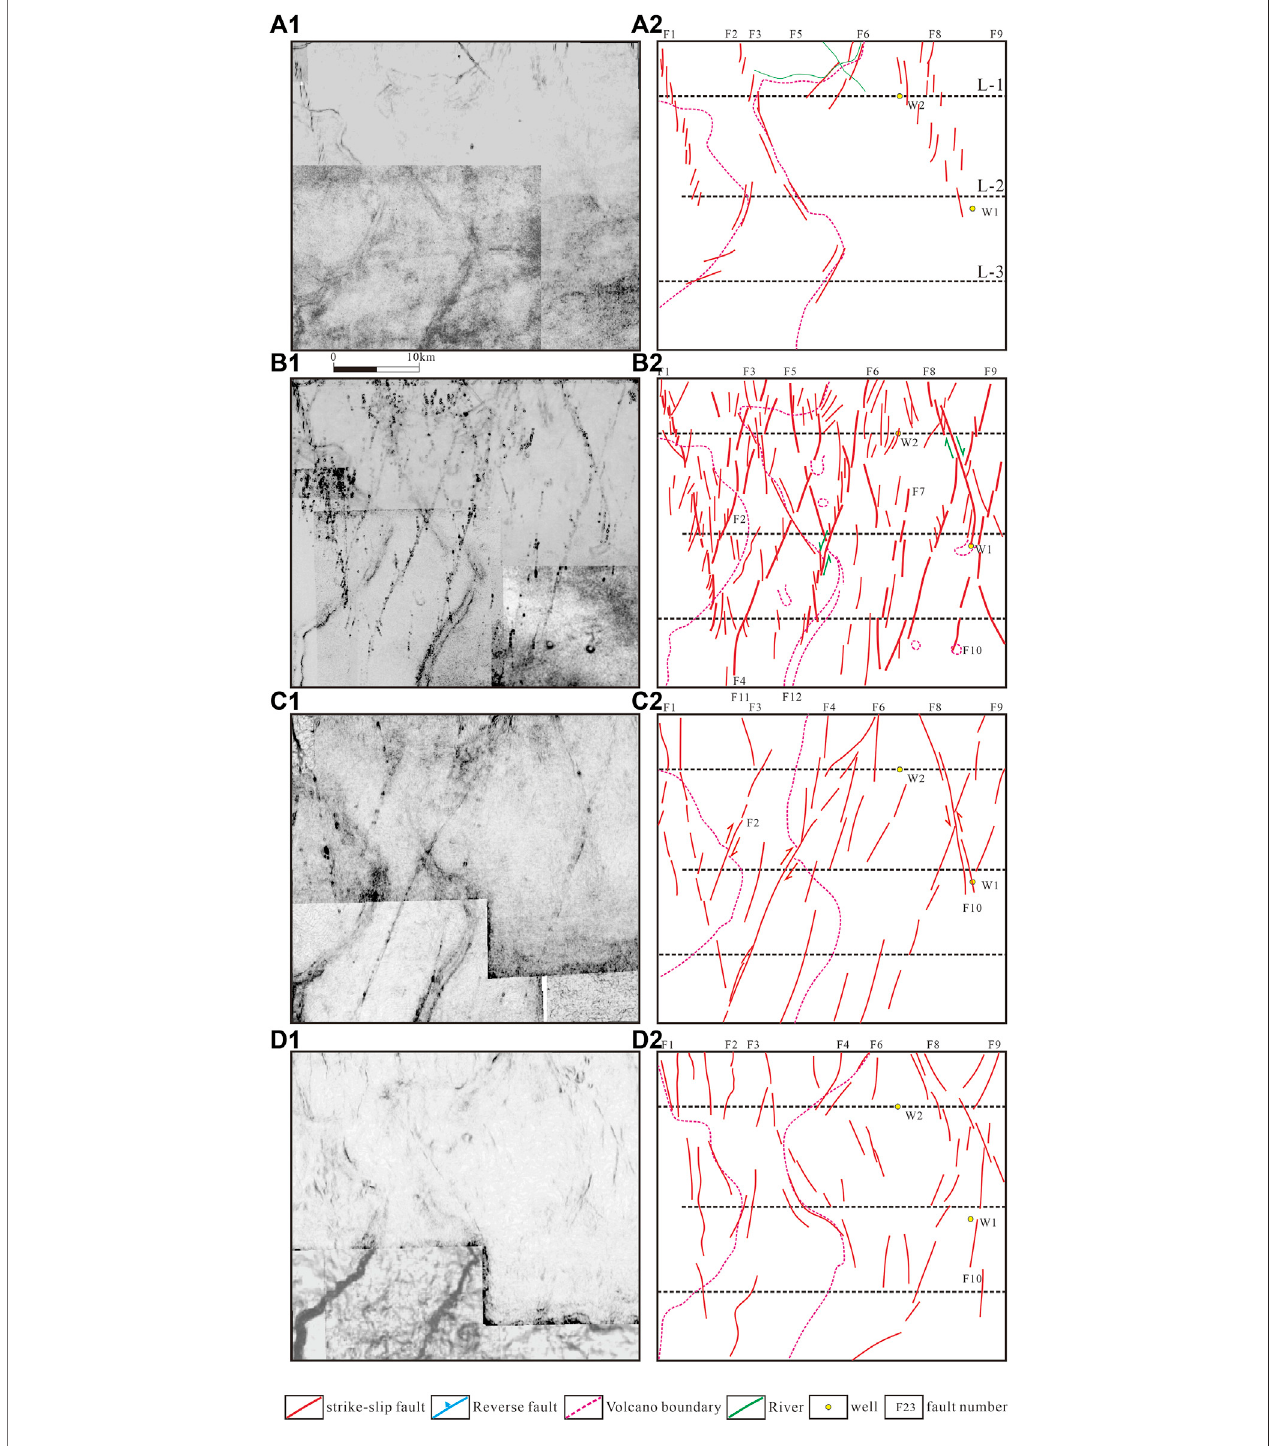
FIGURE 9 | Uninterpreted coherence slices (images to the left in A1 – D1 ; for location, see Figure 5 ) and interpreted fault systems (images to the right in A2 – D2 ) of differentseismicre fl ectionsurfacesoftheTabeiuplift: (A1) Tsre fl ectionsurface(bottomoftheSilurian), (B1) To3re fl ectionsurface(bottomoftheUpperOrdovician), (C1) T Є 3 re fl ection surface (bottom of the Upper Cambrian), and (D1) T Є 1 re fl ection surface (bottom of the Lower Cambrian).